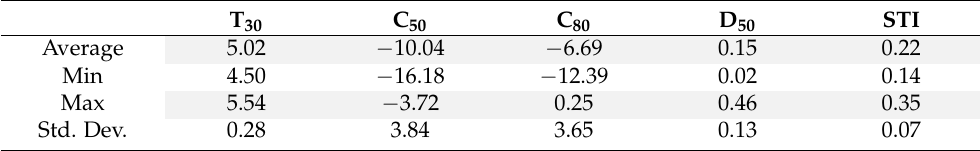
Table 3. Averaged acoustic parameter results at mid-frequencies—Source in position 2. T